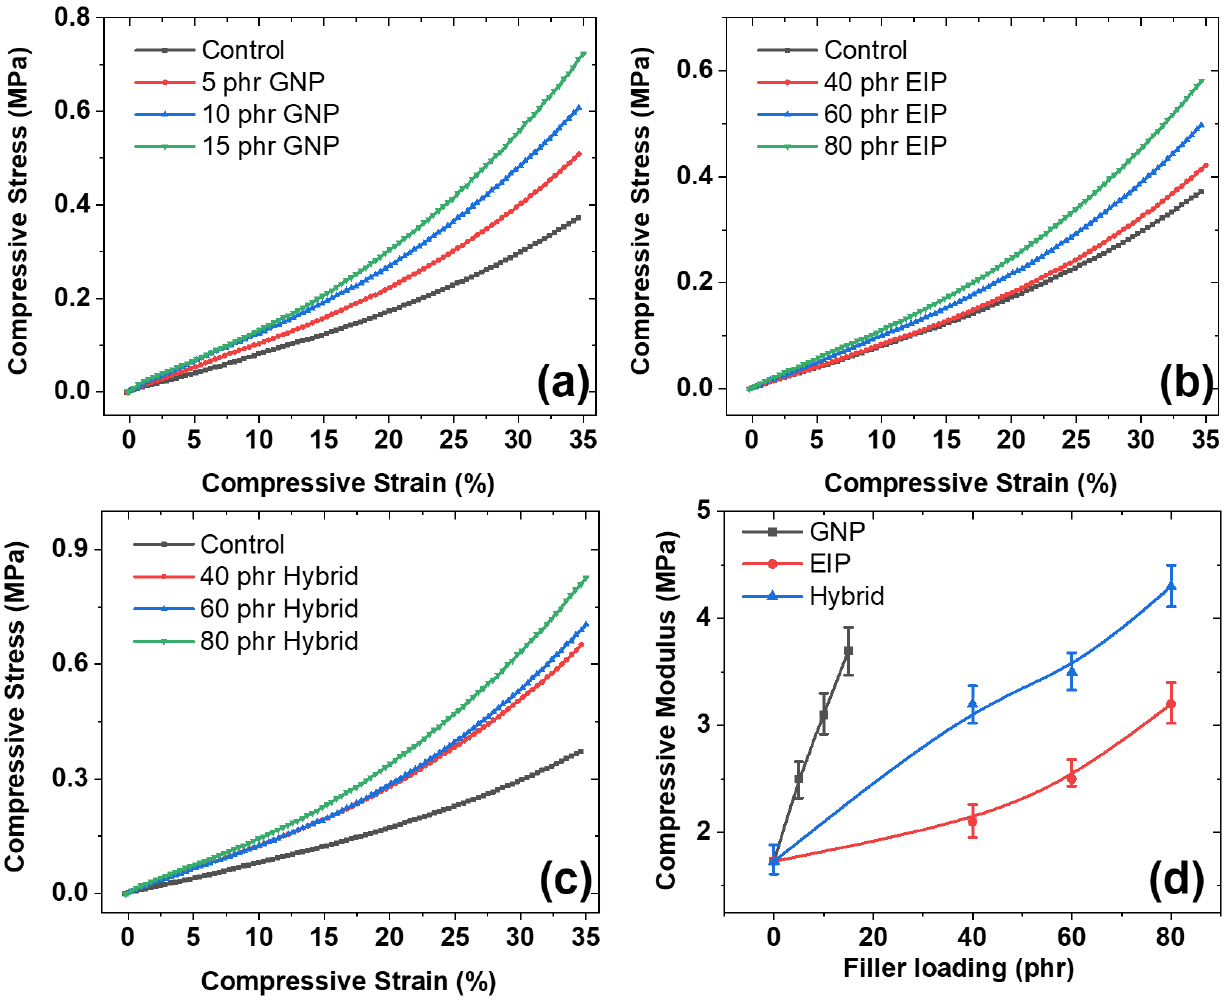
Figure 3. Compressive stress – strain profiles: ( a ) GNP; ( b ) EIP; ( c ) hybrid; ( d ) compressive modulus for different fillers.